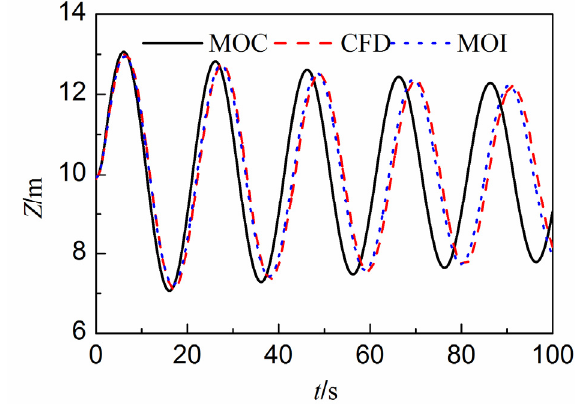
Figure 14. Oscillation of water level for Case 1.